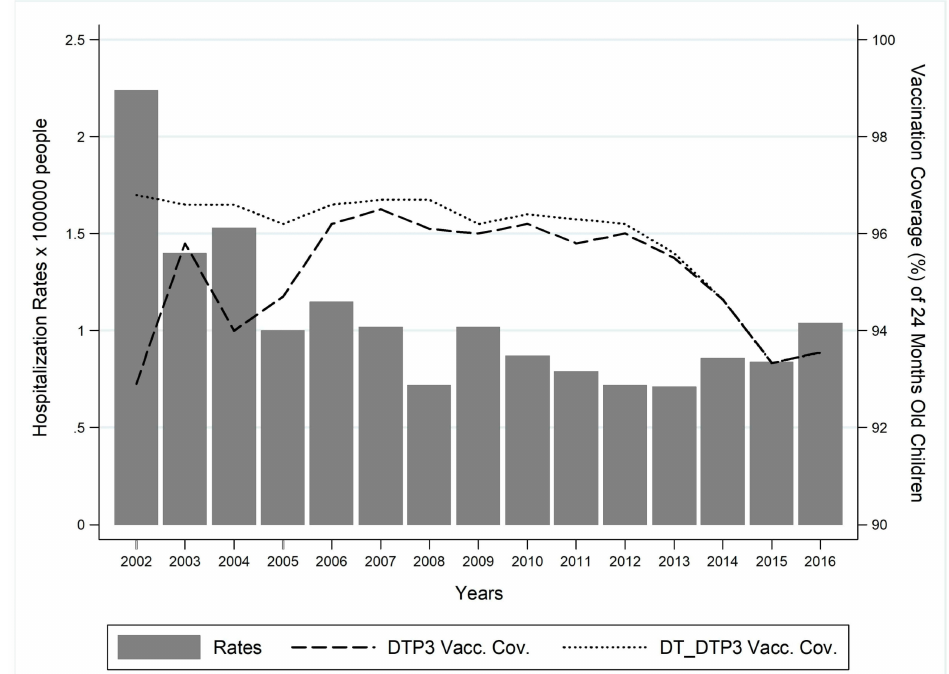
Figure 2. Temporal trend of hospitalization rates and vaccination coverage of 24 months old children for pertussis in Italy (2002 − 2016 time-frame). Trend test. Hospitalization rates: β coe ffi cient = − 0.06; p = 0.003. DTP3 coverage: β coe ffi cient = − 0.20, p = 0.785; DT-DTP3: β coe ffi cient = − 0.20, p <